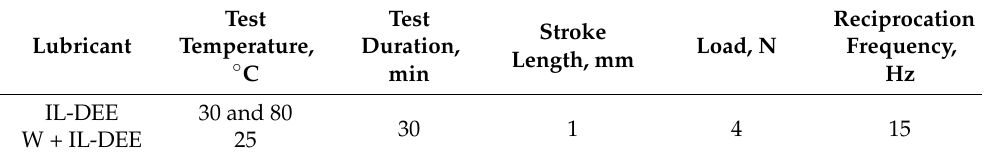
Table 1. Summary of ball-on-plate tribo-test.